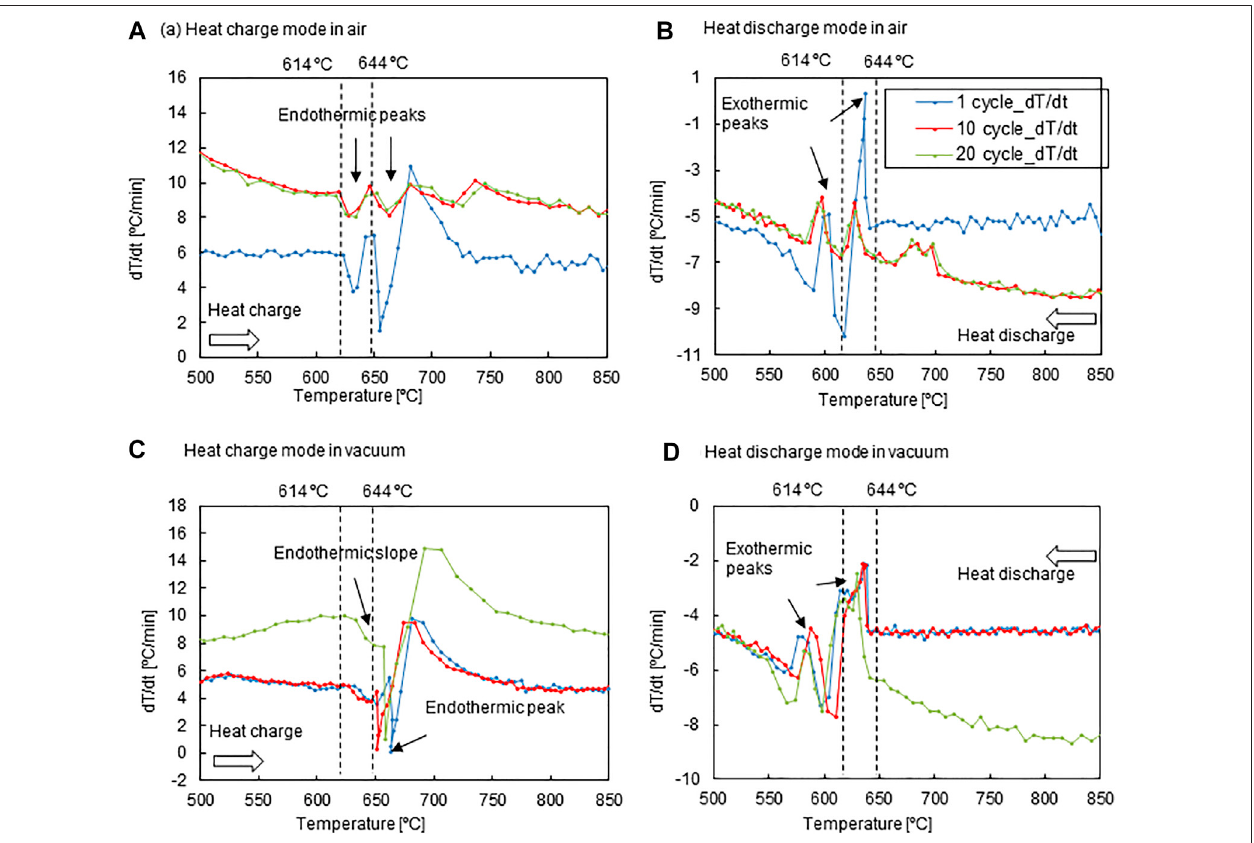
FIGURE 7 | d T /d t variations of the PCM temperature for the CuGe40 alloy in an air stream during the (A) heat-charge mode and (B) dis-charge mode, and in a vacuum during the (C) heat-charge mode and (D) heat-discharge mode.